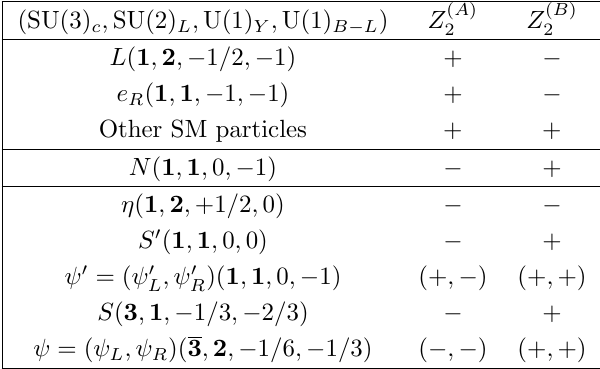
Table 3 . Particle content of the model, together with the corresponding charge assignments. Z ( A ) is broken only by the mass term of the fermion (cid:12)eld 0 . Z ( B ) eq.